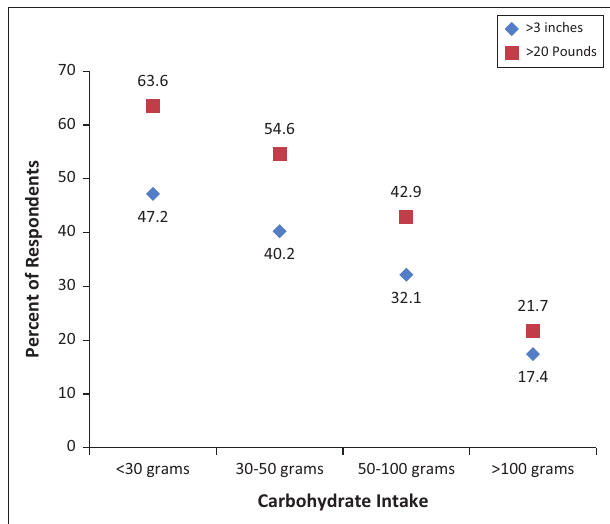
FIGURE 1: Weight and waist circumference loss in relation to carbohydrate intake.